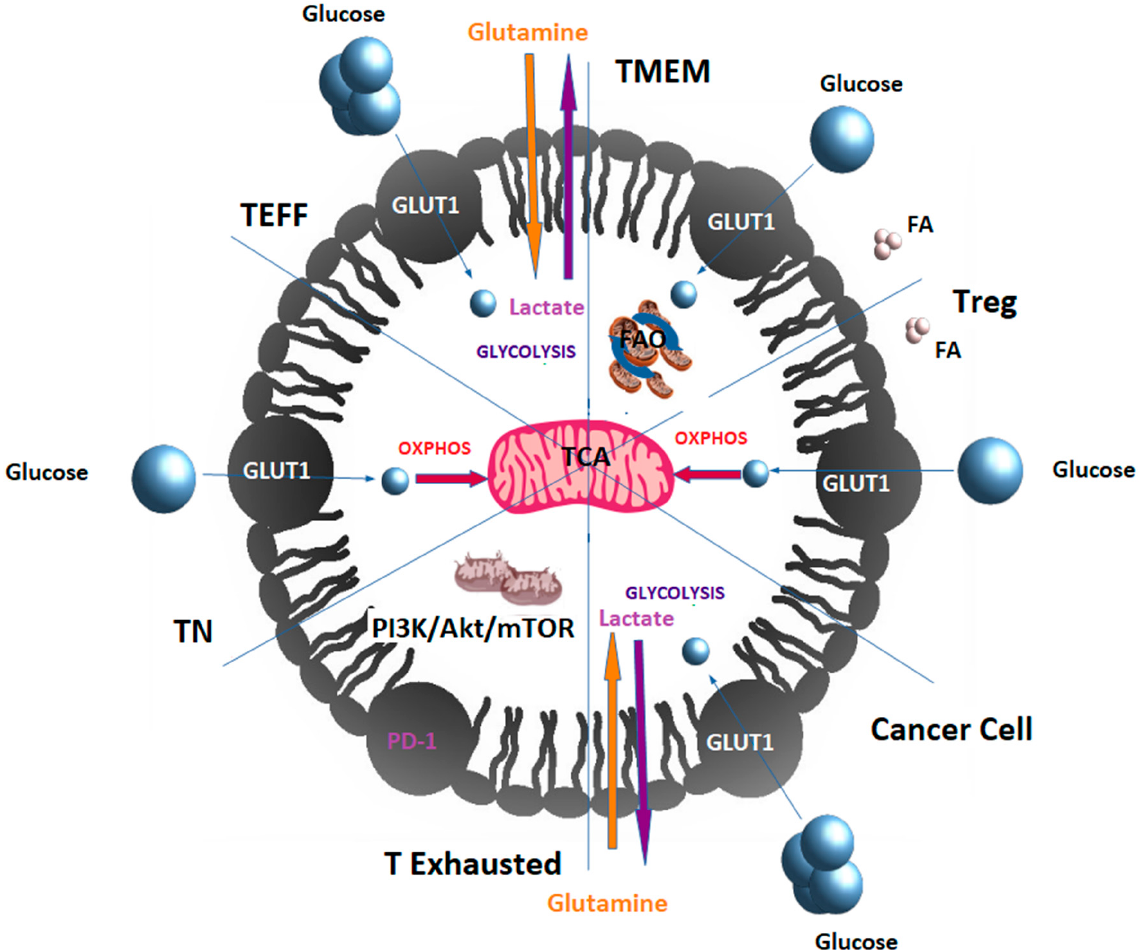
Figure 2. T cells remodel their metabolism to get differentiated into T-cell subsets within the TME. TN cells use glucose that enters in OXPHOS. Upon encountering cognate antigen, activated T cells get differentiated into TEFF, rapidly uptaking glucose and glutamine to perform aerobic glycolysis and generating lactate as a by-product. Once the antigen is cleared, TEFFs can get differentiated into memory T cells (TMEM), which depend on fatty acid oxidation. Equally, cancer cells depend on aerobic glycolysis and glutaminolysis that are fueled by glucose and glutamine, respectively, with production of lactate as a by-product. TEFF within the TME can be differentiated into Tregs with immunosuppressive properties that mainly produce energy by oxidative phosphorylation (OXPHOS) and fatty acid oxidation (FAO). T cells can become exhausted if they fail to clear antigens, as, for example, in cancer. T lymphocytes derived from tumors show elevated levels of PD-1 decreasing PI3K/Akt/mTOR signaling pathway and therefore glycolysis. Exhausted T cells in tumors having often dysfunctional mitochondria rely on FAO. FA: fatty acids. Cancer cells and T cells compete for nutrients, since cancer cells also have an increased glucose and glutamine uptake and they use aerobic glycolysis with production of lactate that is exported to the extracellular space, promoting acidification in the TME that compromises the activity of immune cells.